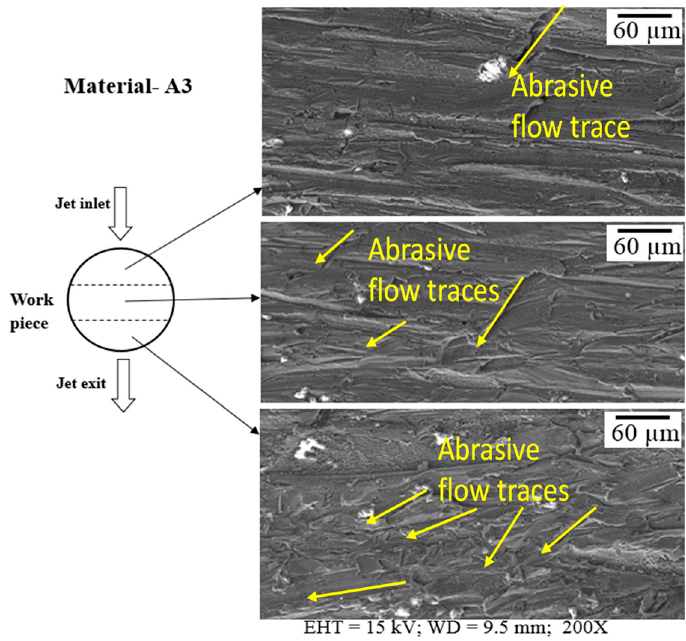
Figure 6. Surface along the depth of sample A3 after machining.